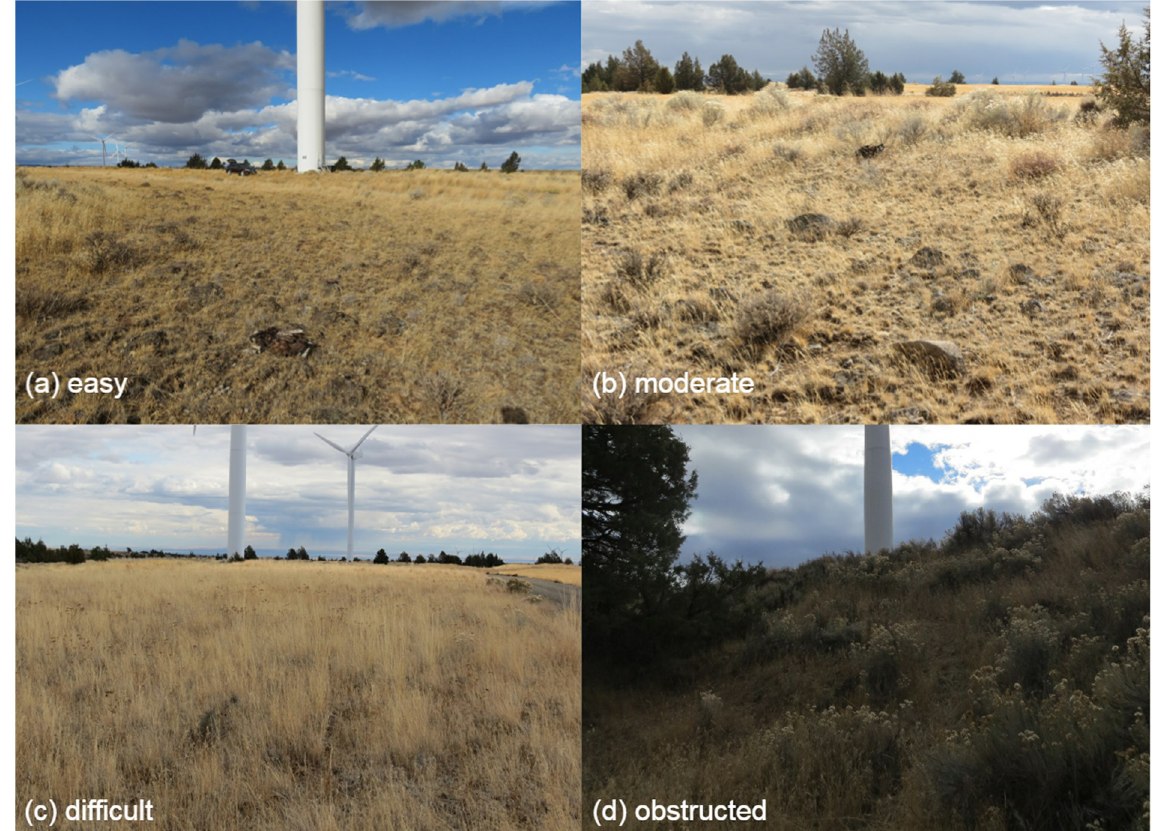
Fig 4. Examples of visibility classes present with search plots. (a) easy, (b) moderate, (c) difficult, (d) obstructed.